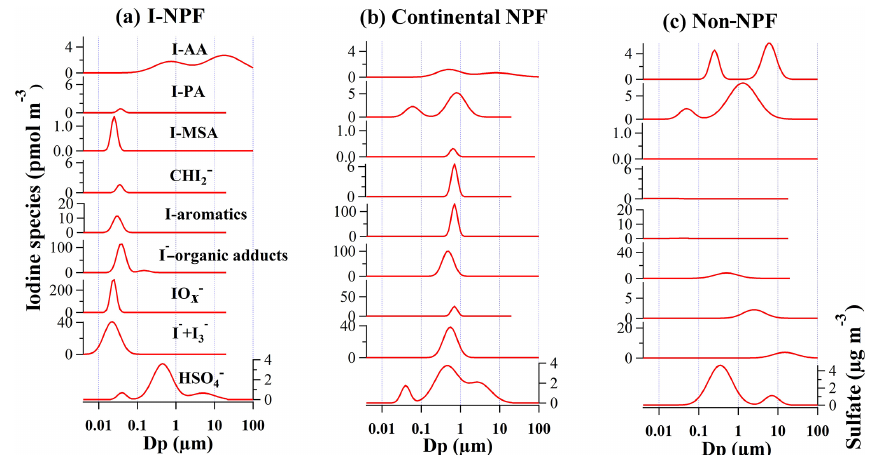
Figure 9. Mass size distribution of iodine species in 10nm–18µm particles during (a) iodine-induced NPF (I-NPF) days, (b) continen- tal NPF days, and (c) non-NPF days. Continuous size distributions of iodine species were inverted from the measured mass concentra- tions in the 13 size bins of nano-MOUDI. Y axis is shown as d C/ dlog D p . I-AA: the sum of iodoacetic acid and diiodoacetic acid; I- PA: iodopropenoic acid; I-MSA: iodomethanesulfonic acid; CHI − : diiodomethane; I-aromatics: total aromatic iodine compounds; IO − x 2